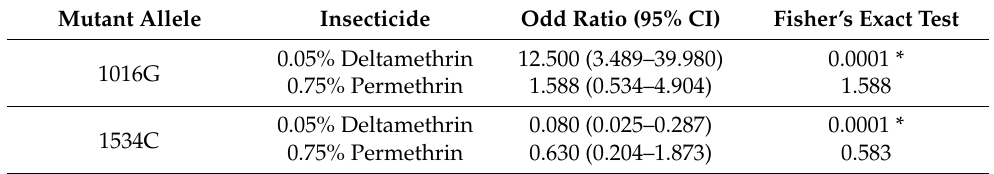
Table 4. Association between V1016G and F1534C alleles with resistance phenotype to deltamethrin and permethrin in adult Ae. aegypti .